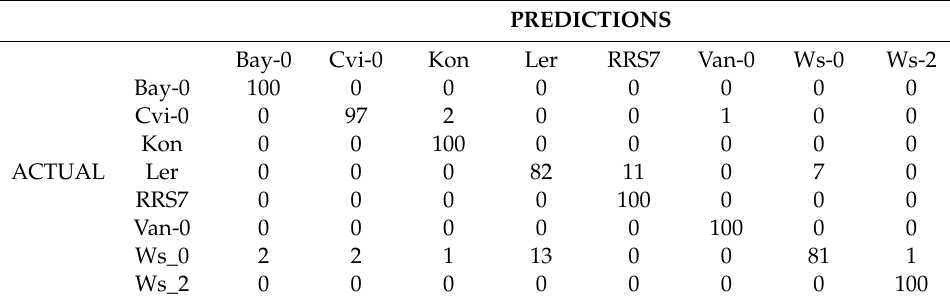
Table A4. Confusion matrix for shoots using only the most identifiable